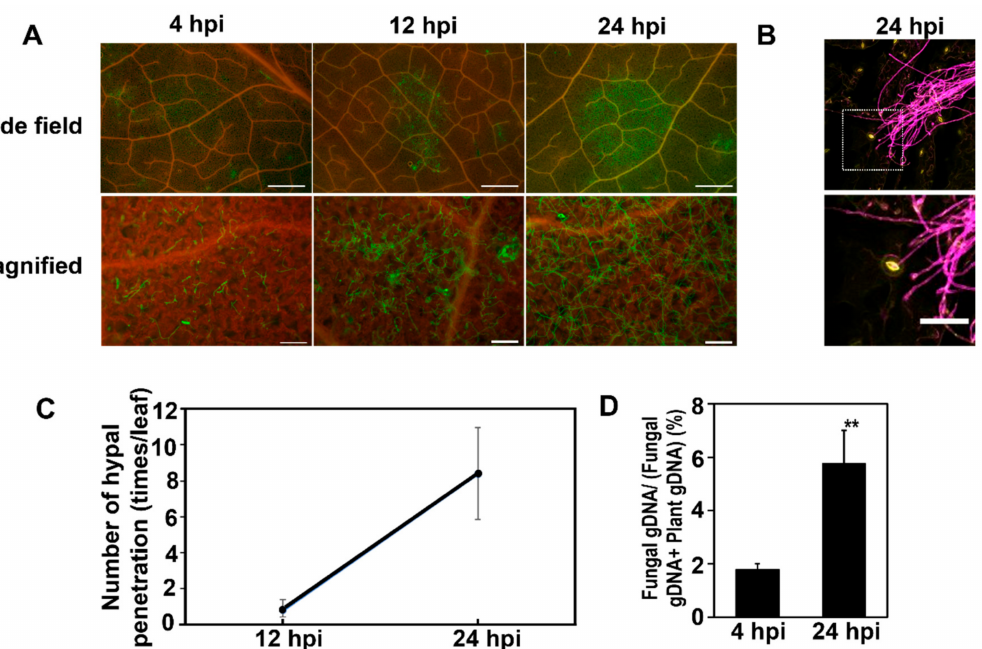
Figure 1. Analysis of F. graminearum colonization on the surface of Arabidopsis leaves at 4, 12, and 24 h post-inoculation (hpi). ( A ) Visualization of fungal hyphae stained with WGA-Alexa488 (green) under a fluorescence microscope at 4 and 24 hpi. Red represents chlorophyll autofluorescence. Bars of wide field = 1000 µ m and bars of high magnification = 100 µ m. ( B ) Mycelium stained by WGA-Alexa 488, and stomata cells stained by PI. Yellow fluorescence is stomata, whereas the purple one is mycelium. Bar = 5 µ m. ( C ) Rate of entry of fungal hyphae into leaf tissues. Data represent mean ± standard error. ( D ) Quantification of fungal genomic DNA (gDNA) using quantitative PCR (qPCR). Fungal gDNA was quantified in the leaf epidermis at 4 and 24 hpi. Error bars represent standard deviation ( n = 3), and asterisks indicate significant difference (** p < 0.001; Student’s t -test).